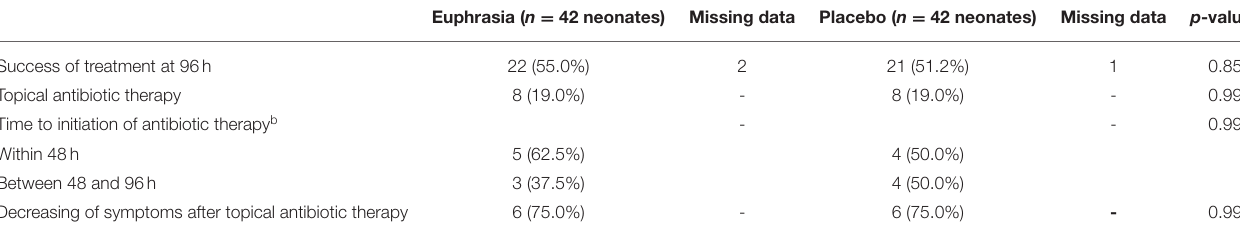
TABLE 4 | Treatment success at 96h (primary outcome) and use of topical antibiotic therapy according to treatment arm ( n = 8 4 neonates).